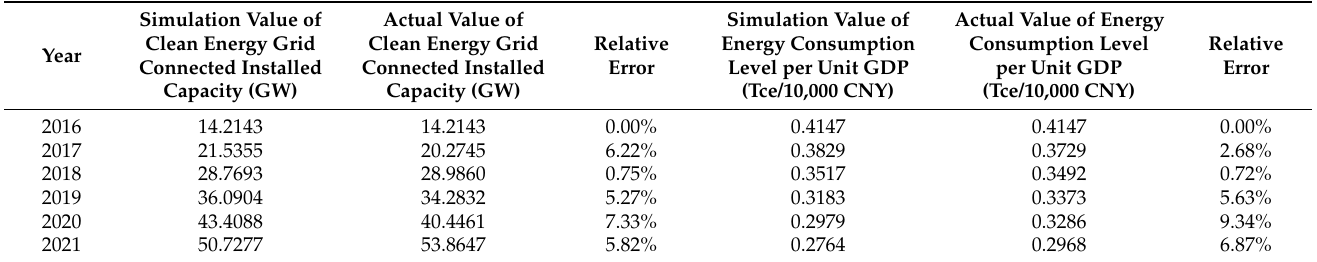
Table 3. Comparison between simulation value and actual value of key indicators of environmental investment.